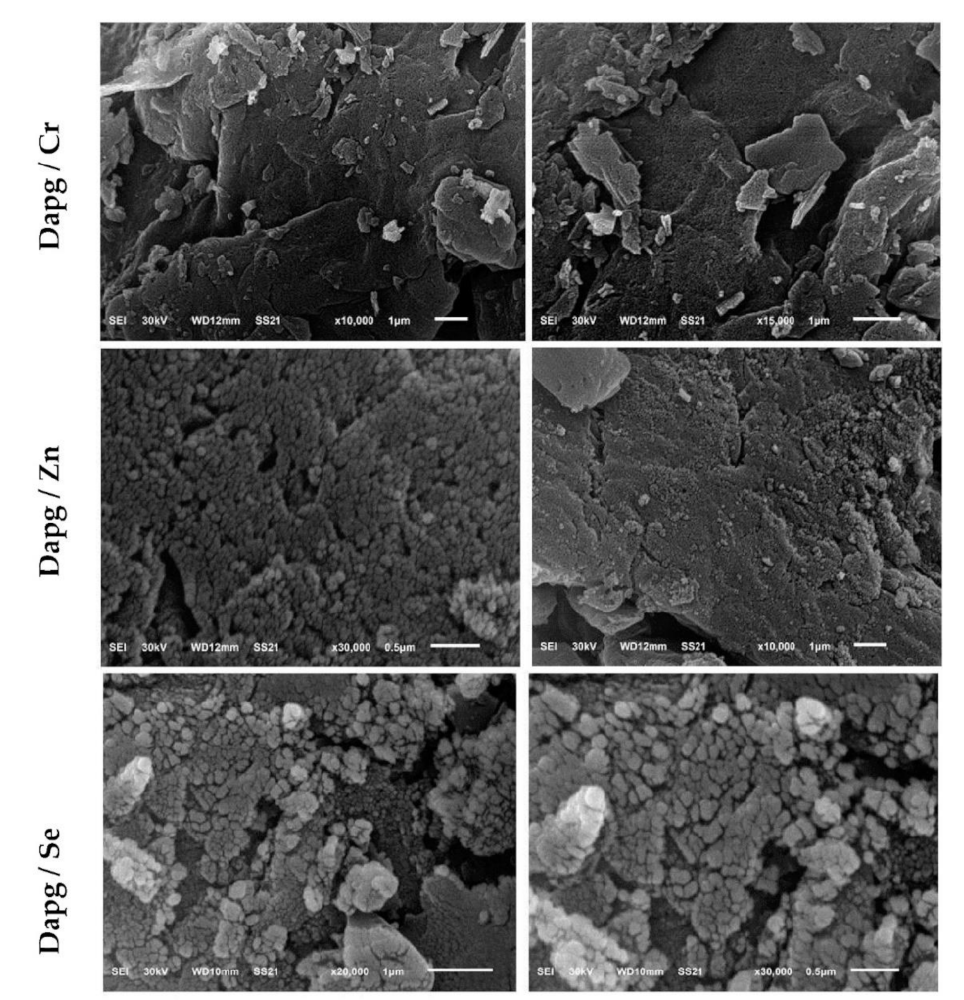
Figure 5. SEM image of Dapg complexes (Cr–Dapg, Zn–Dapg and